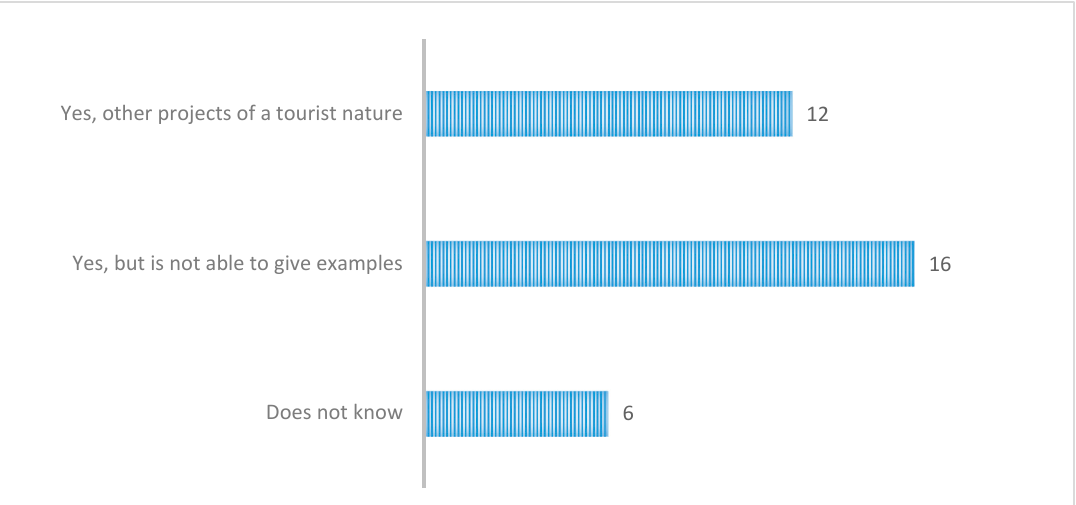
Figure 5. Do you think Proder has been able to encourage other people to undertake projects similar to yours? Examples? Source: Own elaboration .